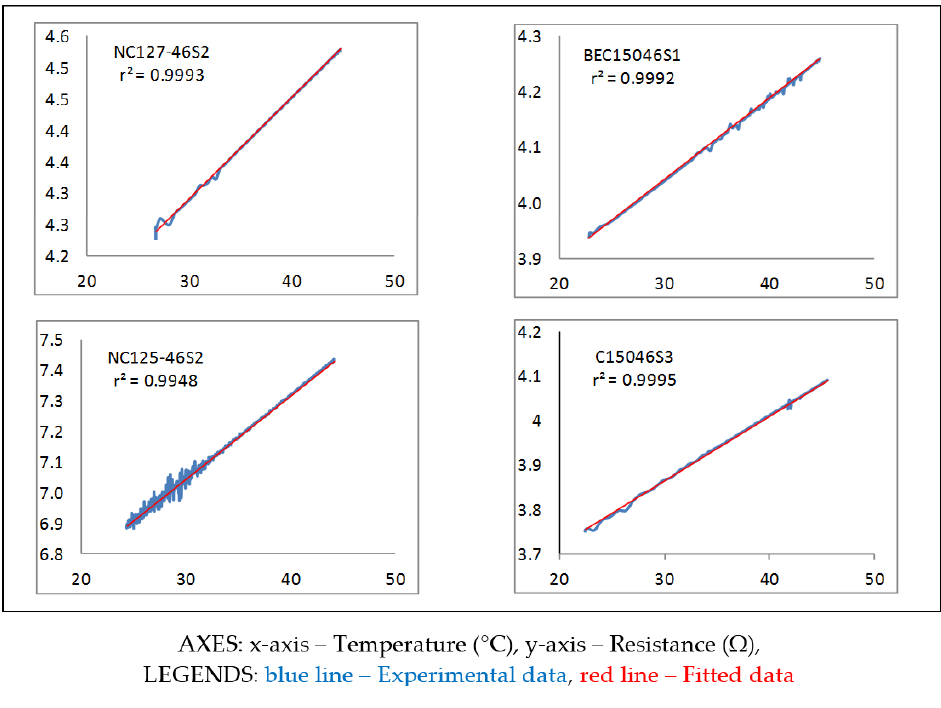
Figure 18. Few unusual repeats of TSF samples inlaid with Cu-based sensing elements of low nominal resistance.